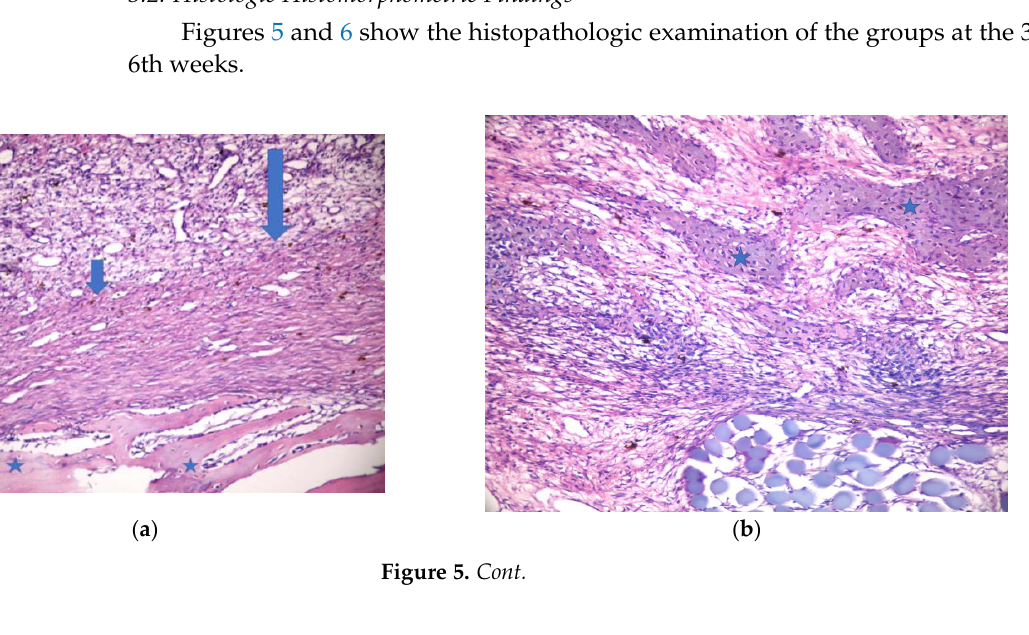
( d ) ( e ) Figure 5. Week 3. ( a ). Empty defect group . Dense vein proliferation in the defect area and fibrosis are observed. Active osteoblasts around the bone stand out in the new bone formation areas. *: new bone formation areas; arrows: fibrosis (H&E ×200). ( b ). HY defect group. New bone formation in the defect area and hyalinized collagen tissue at the periphery are observed. *: new bone formation areas (H&E ×200). ( c ). G+HY defect group3. Bone formations surrounding the graft material are noticeable. In some areas, new bone formations surrounded by active osteoblasts inside sporadically loose collagen tissues are observed. *: graft material; arrows: new bone formation areas (H&E ×400). ( d ). CM defect group. New bone formation areas forming anastomosis inside active collagen tissue in the defect area, more fibrotic collagen tissue at the periphery. *: new bone formation (H&E ×100). ( e ). G+CM defect group. New bone formation areas and graft residues in sporadically loose collagen tissue are present. Active osteoblasts are observed around trabeculas. *: new bone formation areas; arrows: graft (H&E ×400).